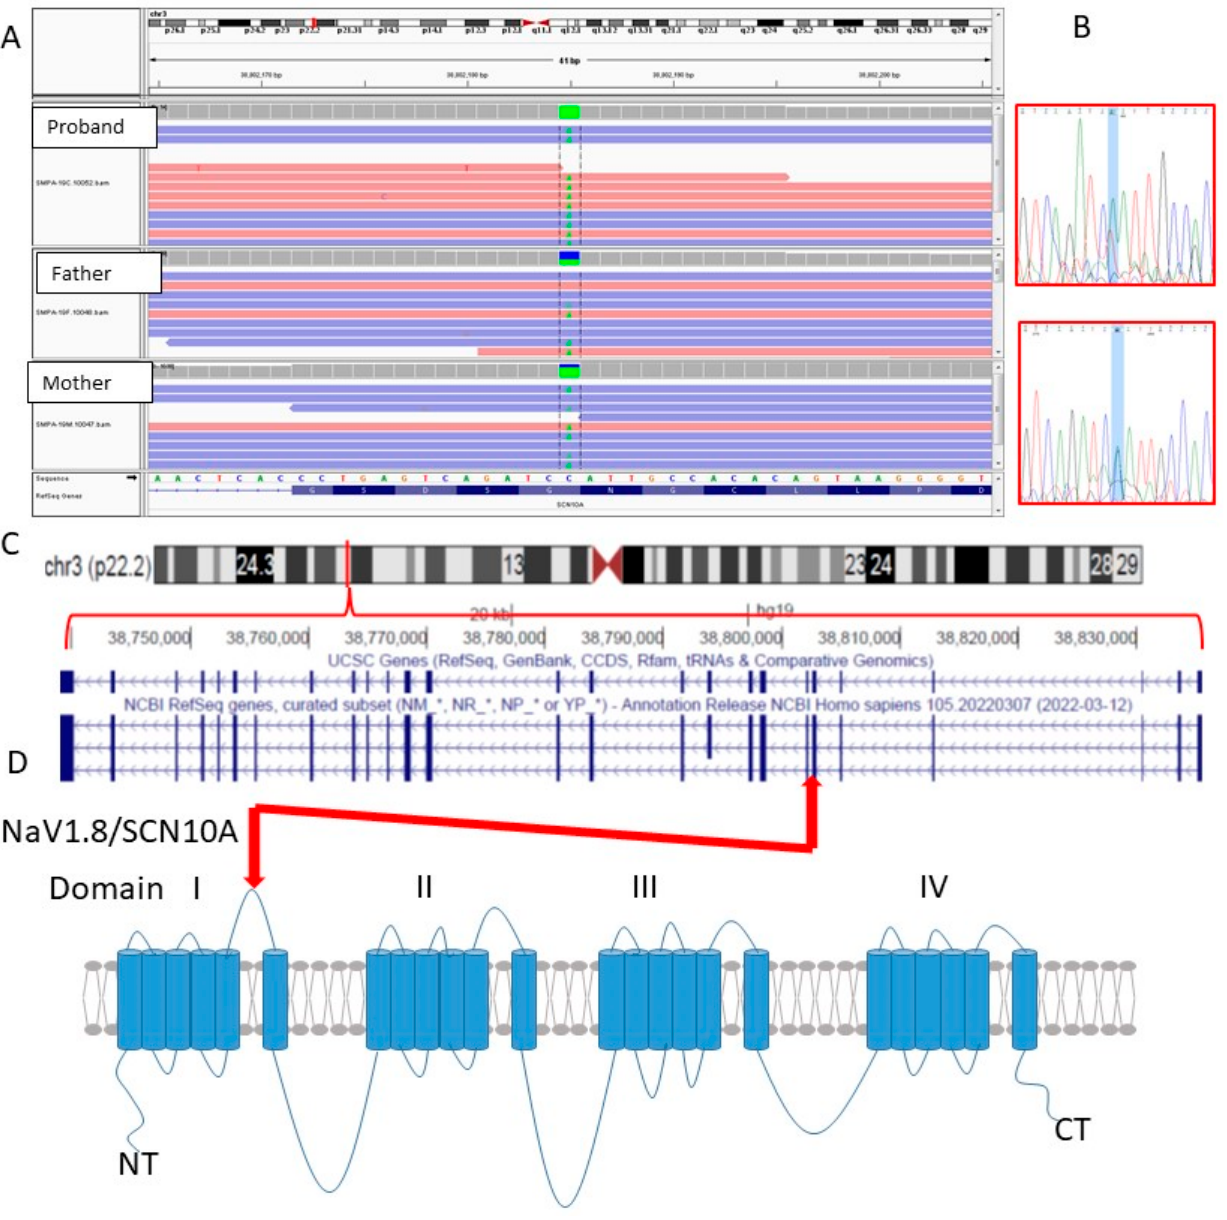
Figure 2. Validation and location of SCN10A variant: ( A ) Integrated Genomics Viewer (IGV, Broad Institute) view of whole exome sequencing reads for SMPA19 proband, mother and father, indicating location within SCN10A transcript. ( B ) Sanger sequence validation for proband and mother (insufficient DNA remaining from father), using FinchTV. Blue shading indicates location of Chr3:38802185C>A variant. ( C ) Ideogram of chromosome 3 indicating location of SCN10A , and genomic structure for the gene. ( D ) Representation of the SCN10A protein in a cell membrane, indicating transmembrane domains, and four main structural domains, I-IV, and position of the biallelic stopgain (nonsense) mutation p.(Gly313*) within the